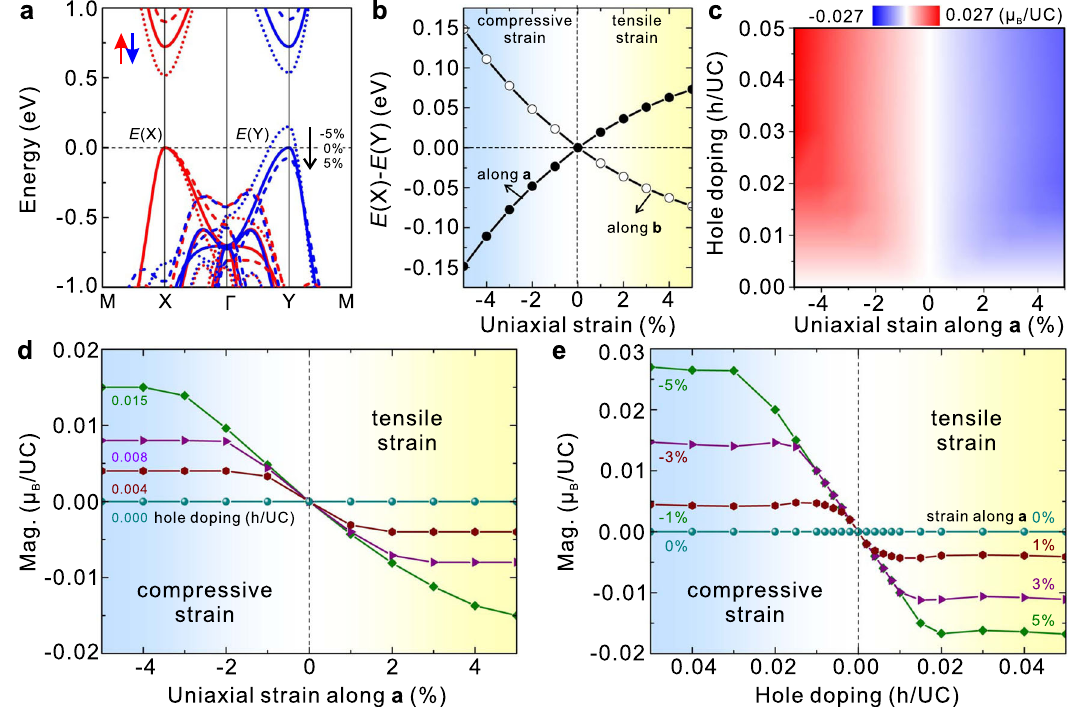
Fig. 3 Strain induced valley polarization and piezomagnetism in hole doped monolayer V 2 Se 2 O. a , Band structure evolution under different uniaxial strains along a direction ( − 5%, 0%, and − 5%). Compared with the energy E (X) at X valley, the energy E Y ð Þ at Y valley monotanesouly shifts down. b Strain induced valley polarization, which de fi ned as the energy difference between two valleys P ¼ E X ð Þ (cid:2) E Y ð Þ . c Diagram of strained induce net magnetization for different hole densities. d For a given hole density, the net magnetization increases linearly with strain but has an opposite direction for compressive and tensile strains in the region of small strains. When strain is large enough, all the carriers are polarized, and the net magnetization saturates. e For any given strain, the magnetization is always equal to the number of holes per unit cell when the doping is light. However, for heavy doping, the magnetization is almost a constant that depends on the